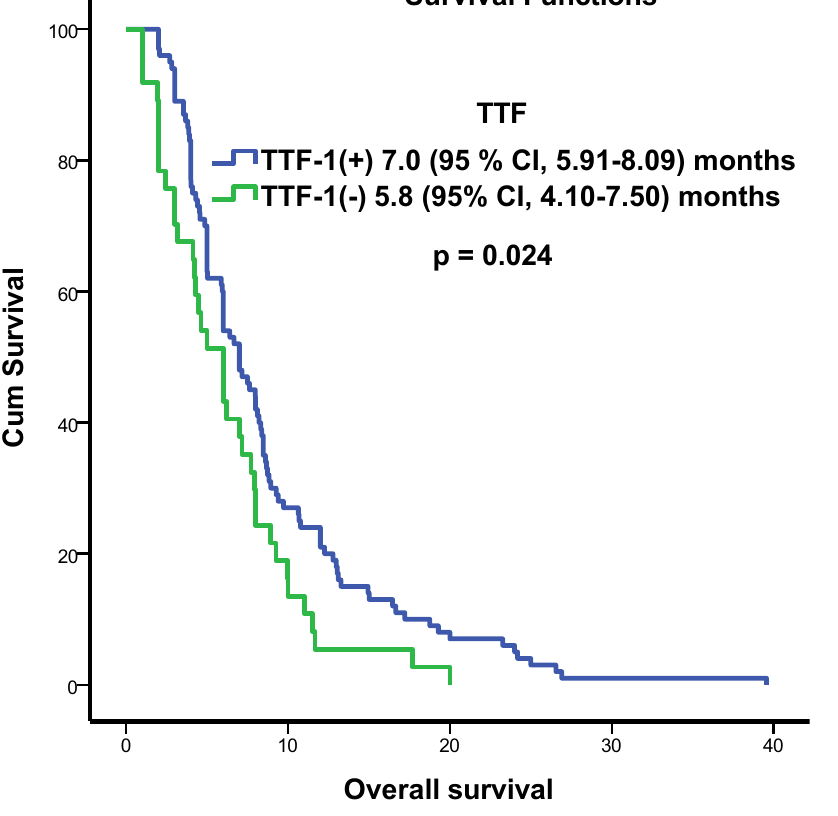
Figure 1. Kaplan–Meier survival curves according to Thyroid transcription factor 1 (TTF-1). The overall survival rates were significantly worse in the TTF-1 (−) group ( p =